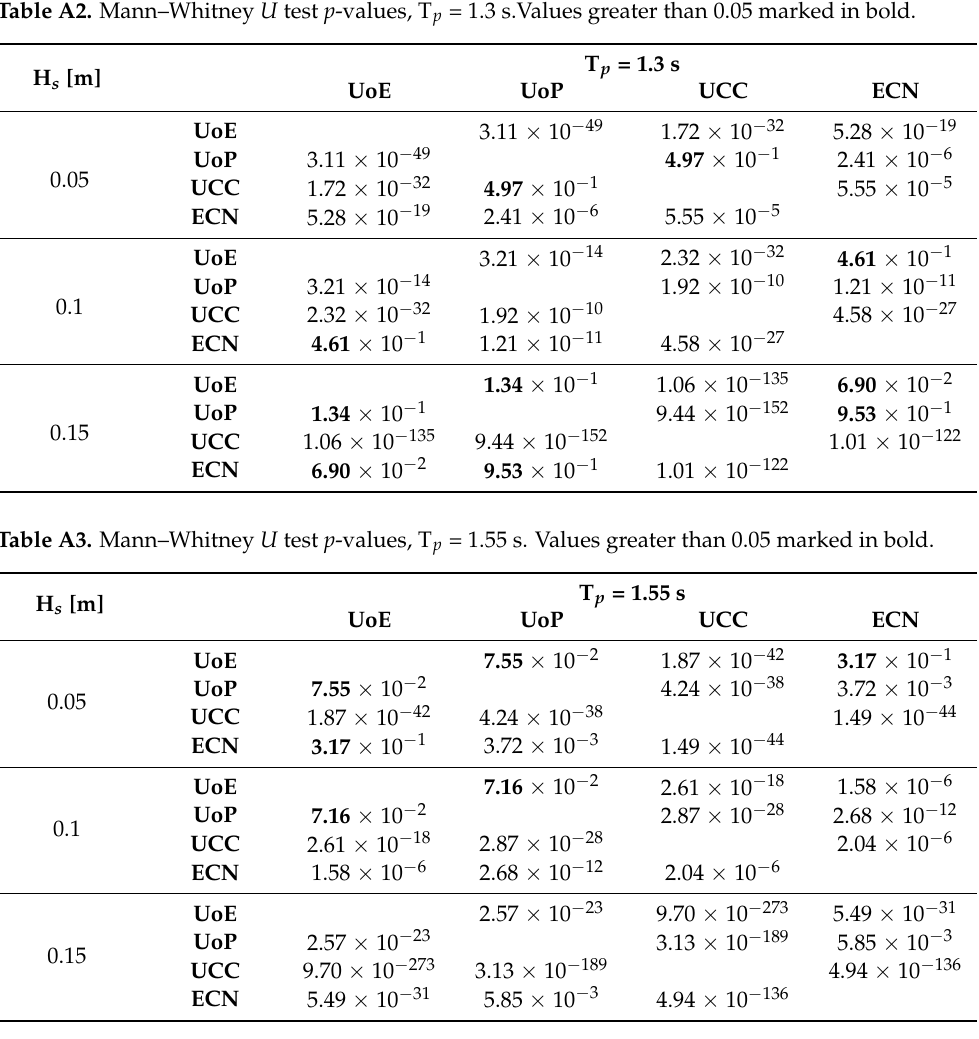
Table A2. Mann–Whitney U test p -values, T p = 1.3 s.Values greater than 0.05 marked in bold.